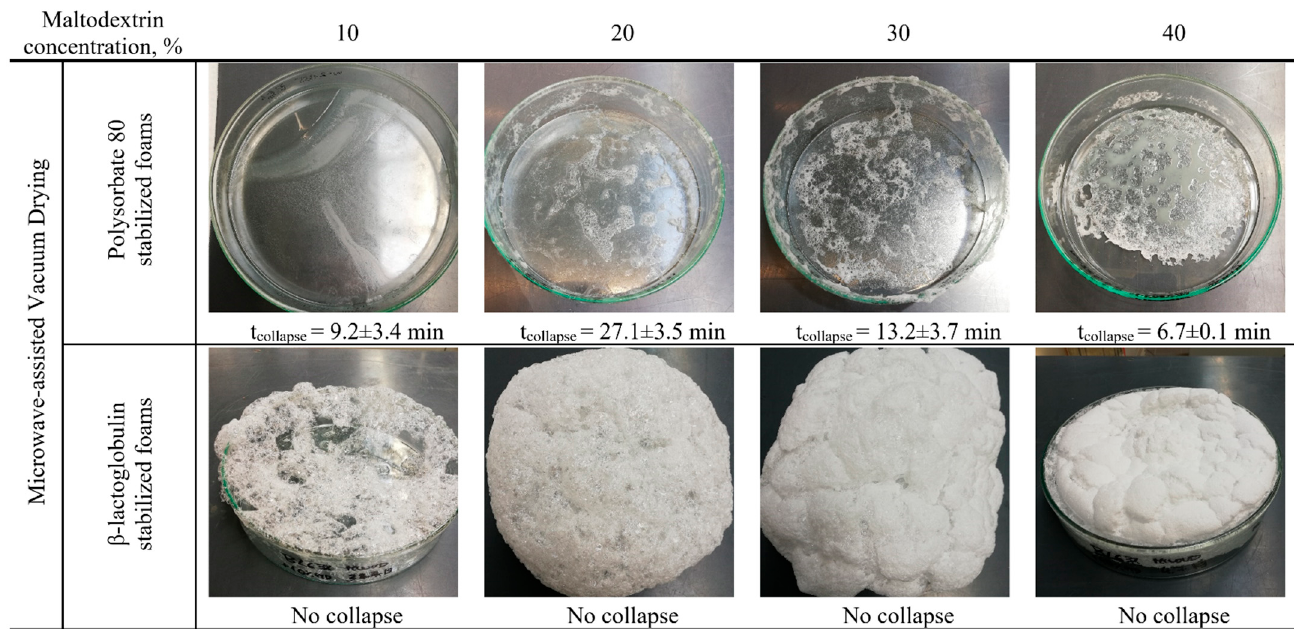
Figure 8. Obtained foam structure after microwave-assisted vacuum drying of polysorbate 80 and β -lactoglobulin foams with a maltodextrin content between 10% and 40%.